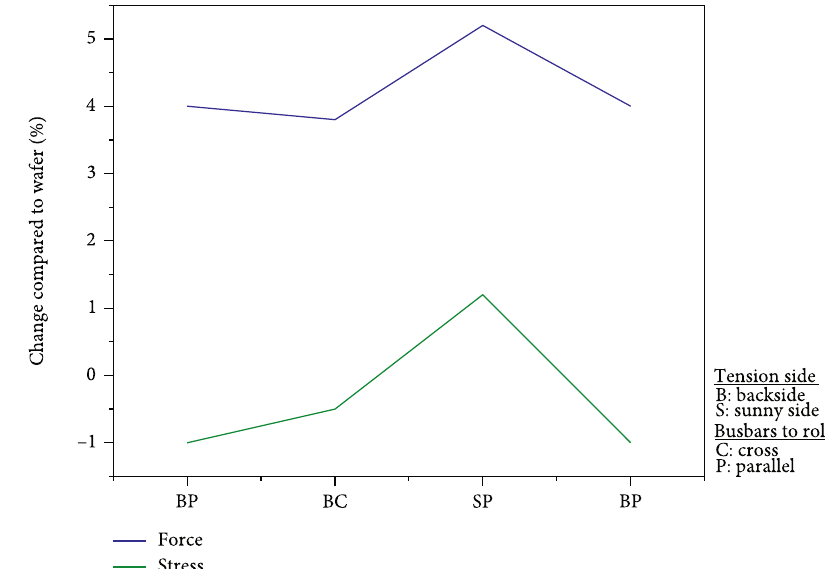
Figure 4: Rollers of variant solar cell designs at 10mm bending have the highest fi rst primary stress and response force of pure silicon (wafer) of the same